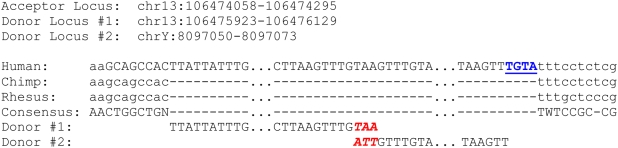
RD where acceptor is a chimera of two different donor sequences.Pre-insertion empty sites for the human-specific RD are shown for chimp and Rhesus macaque. The sequences for donor #1 and donor #2 are shown at the bottom, with a short stretch of base complementarity between the two donors in red, bold, and italics. The filler sequence is in blue, bold, and underlined.